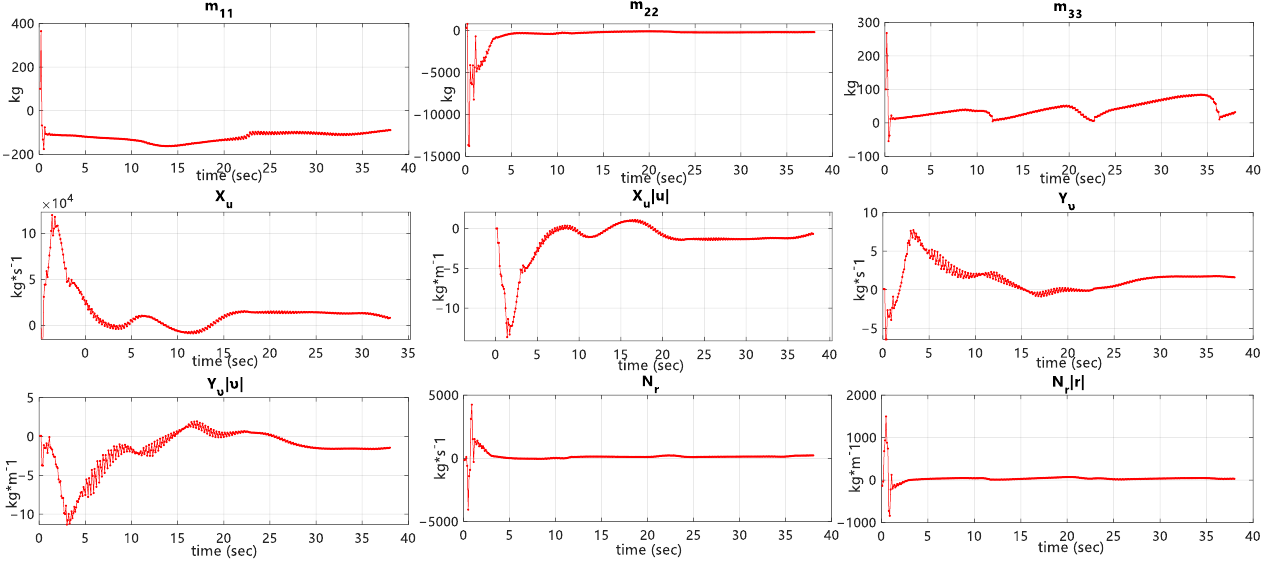
Figure 9. Identification of hydrodynamic derivatives based on the denoised data.